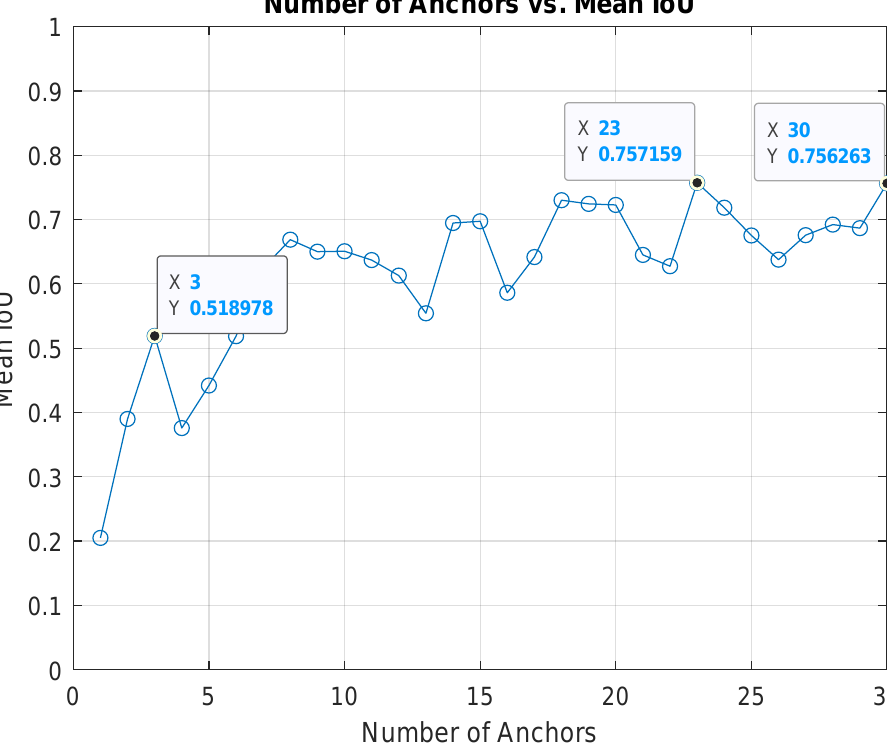
Figure 2. Estimated number of the anchor boxes with the corresponding